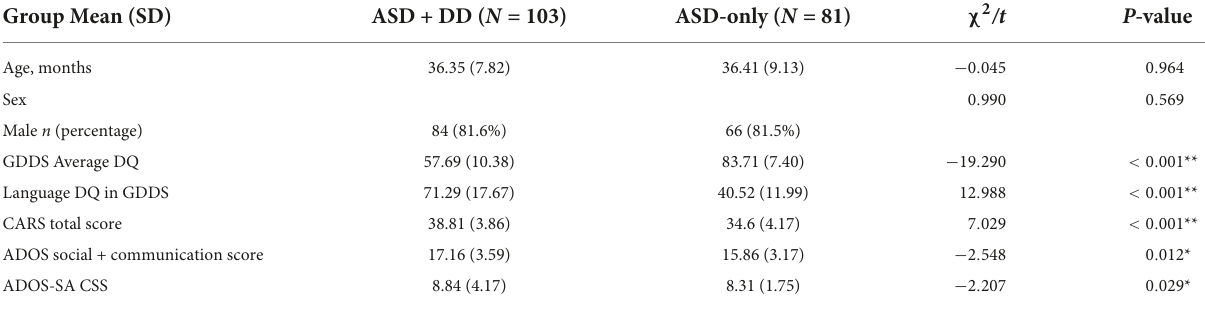
TABLE 1 Comparisons of demographic characteristics and symptom severity in autism spectrum disorder with or without developmental delay. Group Mean (SD)